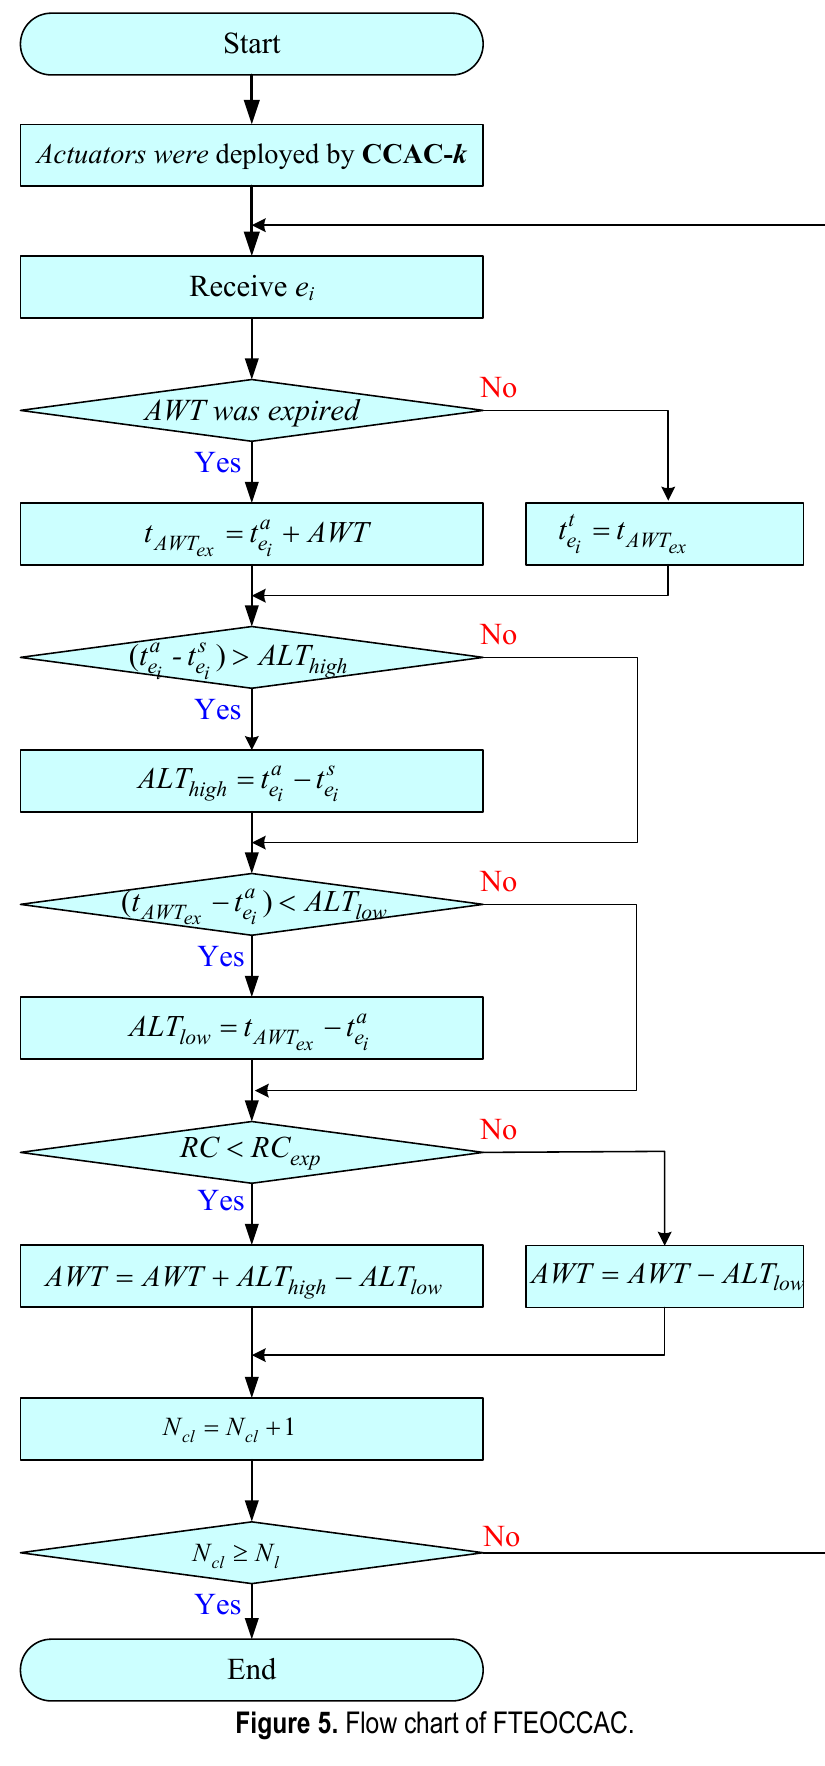
Figure 5. Flow chart of